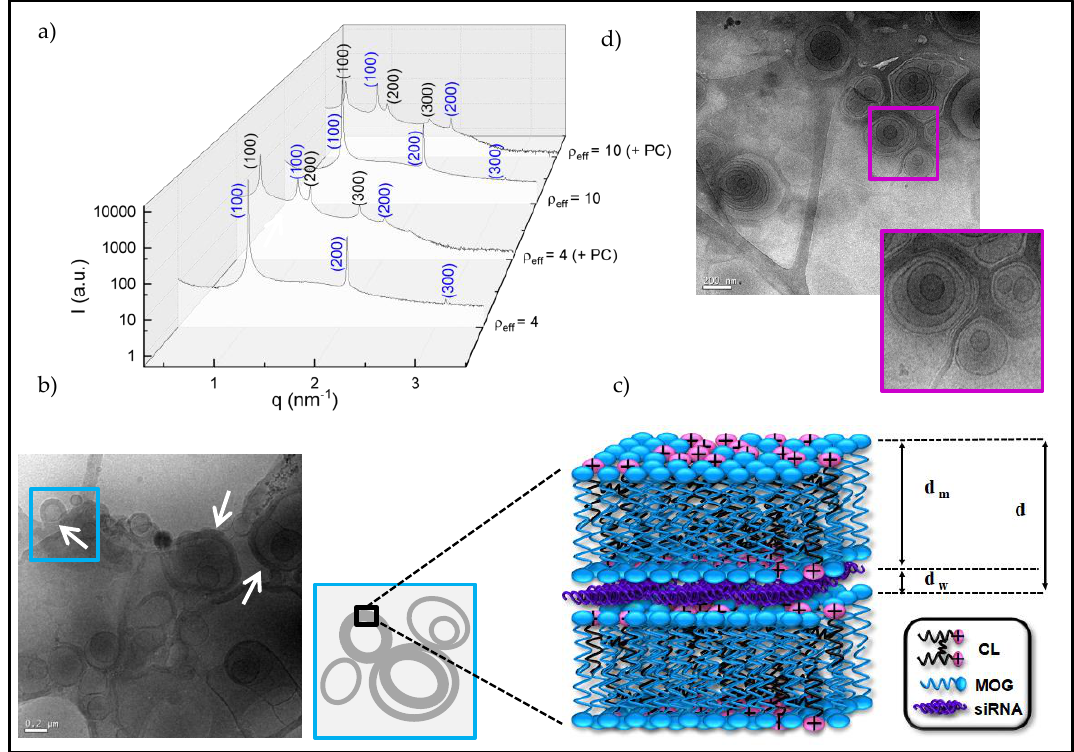
Figure 2. ( a ) SAXS diffractograms of the C 3 (C 16 His) 2 /MOG-siRNA lipoplexes at α = 0.2 and ρ eff = 4 and 10 in the absence and presence of human serum (+ PC). ( b ) Cryo-TEM micrograph of the lipoplexes at ρ eff = 10 and α = 0.2. ( c ) Scheme included the multilamellar structure of lipoplexes aggregated in cluster-type shapes. ( d ) Cryo-TEM micrograph of C 3 (C 16 His) 2 /MOG lipid mixture. Scale bars of micrographs at 200 nm. Table 1. Values of the periodic distance of the lamellar structure, d, for C 3 (C 16 His) 2 /MOG-siRNA lipoplexes at α = 0.2 and ρ eff = 4 and 10 in the absence and presence of human serum (+ PC). The primary L α structure is in blue, and the secondary L α structure is in black, the same color codes as in diffractograms (Figure 2). Values of q hkl (nm −1 ) and d hkl (nm) are estimated with a 5% error. α = 0.2